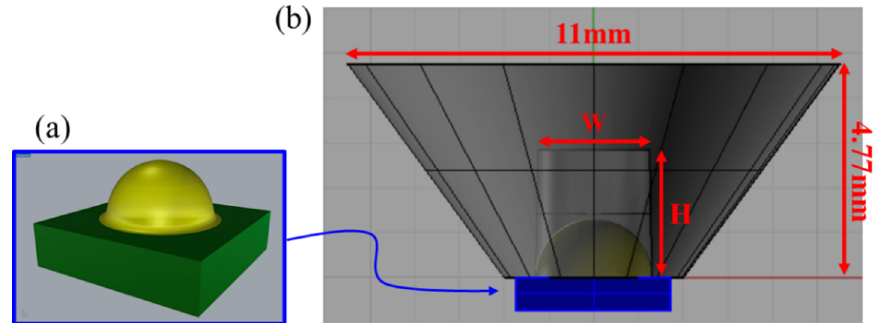
Figure 3. ( a ) XPE and ( b ) total internal reflection (TIR) lens structures.